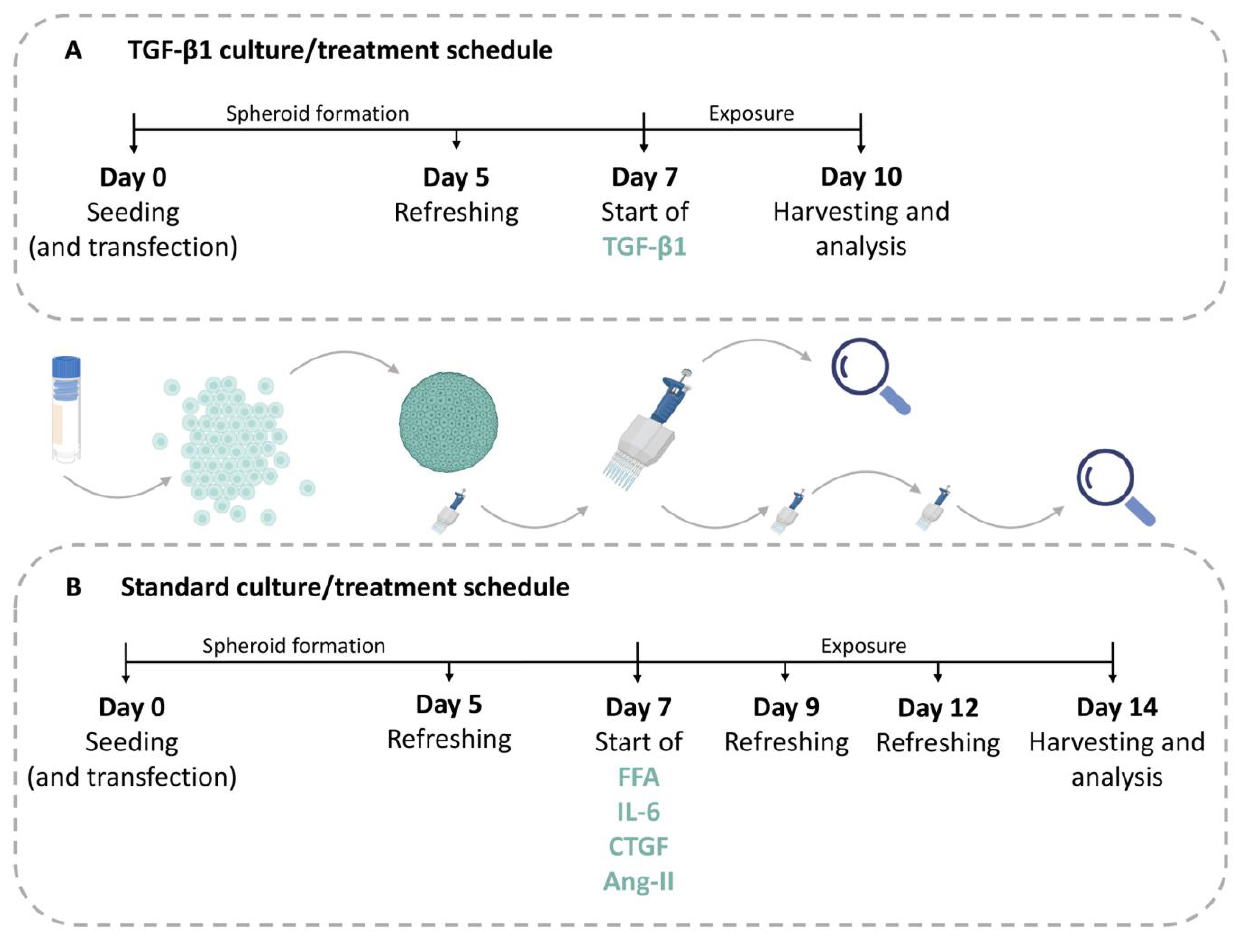
Figure 1. Schematic overview of experimental setup. ( A ) For analyses of effects of TGF- β 1 treatment the cells were seeded (day 0) and cultivated to form spheroids for 5 days when the first medium refreshment occurred. TGF- β 1 treatment started on day 7 and lasted for 3 days, after which the spheroids were harvested. When required, siRNA and transfection reagents were added during seeding at day 0 to achieve a high transfection efficiency. Following transfection, the cells were treated as above. ( B ) In the standard treatment schedule, the cells were seeded on day 0 and the first medium refreshment took place on day 5. All treatments of FFA, IL-6, CTGF, or angiotensin II (Ang-II), started on day 7 and lasted for 7 days. Medium and compounds were refreshed every 2 to 3 days, until the spheroids were harvested. In experiments, where cells were transfected, this took place on day 0 along with the seeding procedure. TGF- β 1—transforming growth factor beta 1; FFA—free-fatty acids; IL-6—interleukin 6; CTGF—connective tissue growth factor; Ang-II—angiotensin II. Parts of the figure were created with BioRender.com.